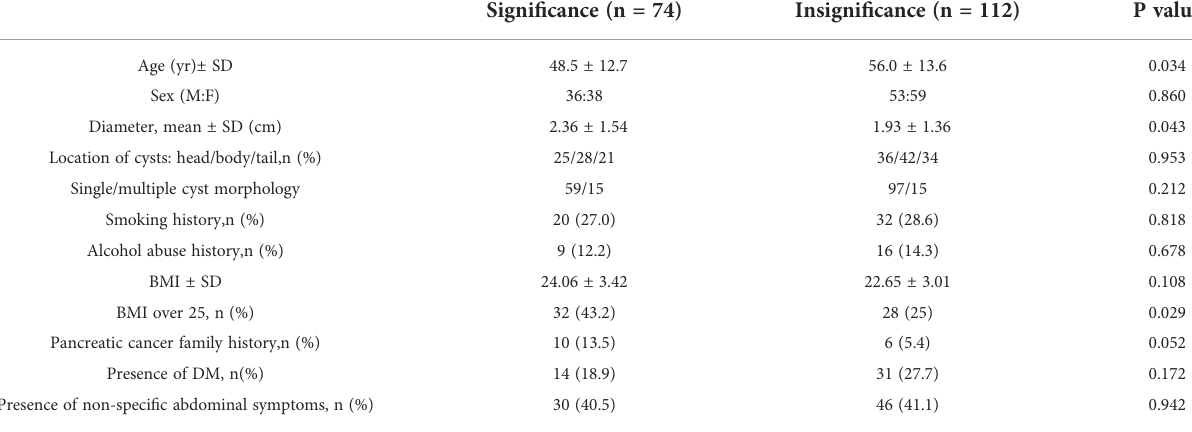
TABLE 2 Comparisons of the clinical and imaging feature between signi fi cance and insigni fi cance